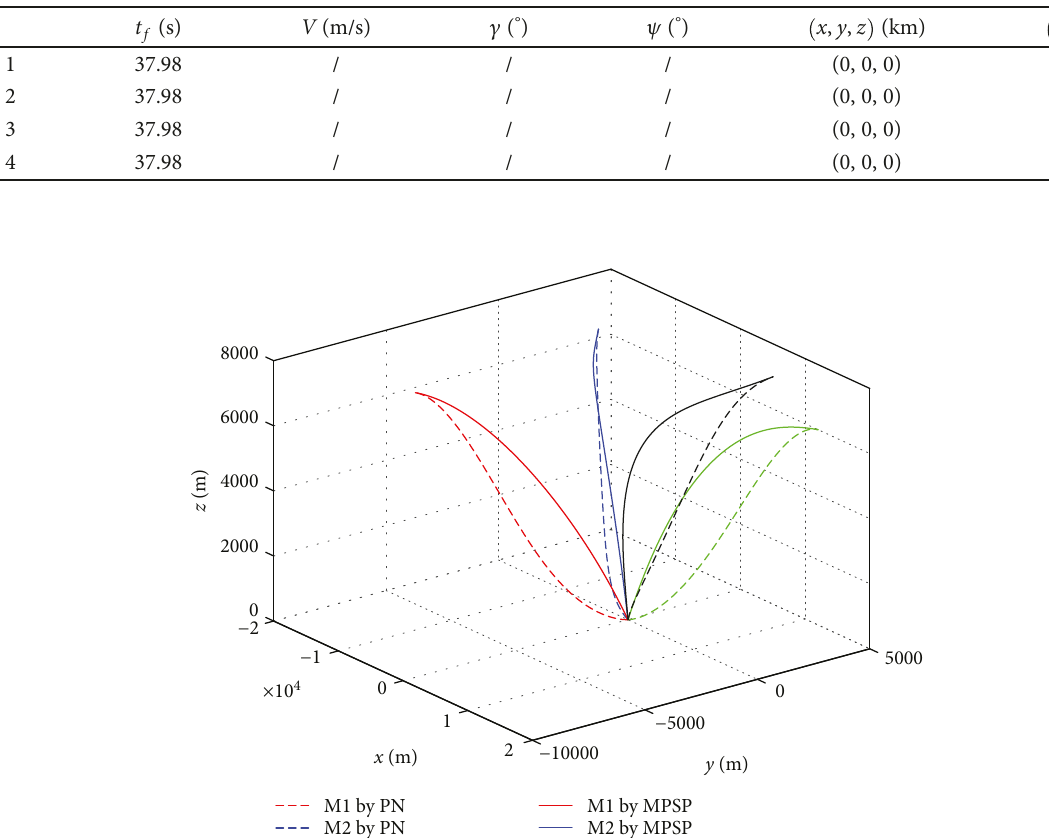
Table 3: Terminal constraints with impact time